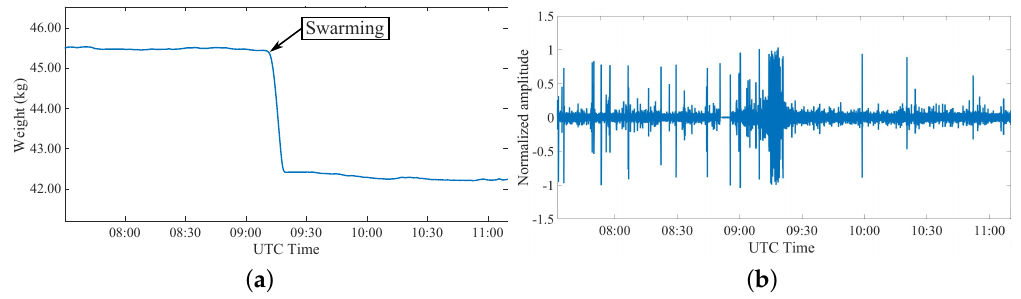
Figure 12. Third event: measurement during the swarming event in colony 1 during a day in April 2019 considering ( a ) weight variations and ( b ) related changes in recorded sound inside the colony.